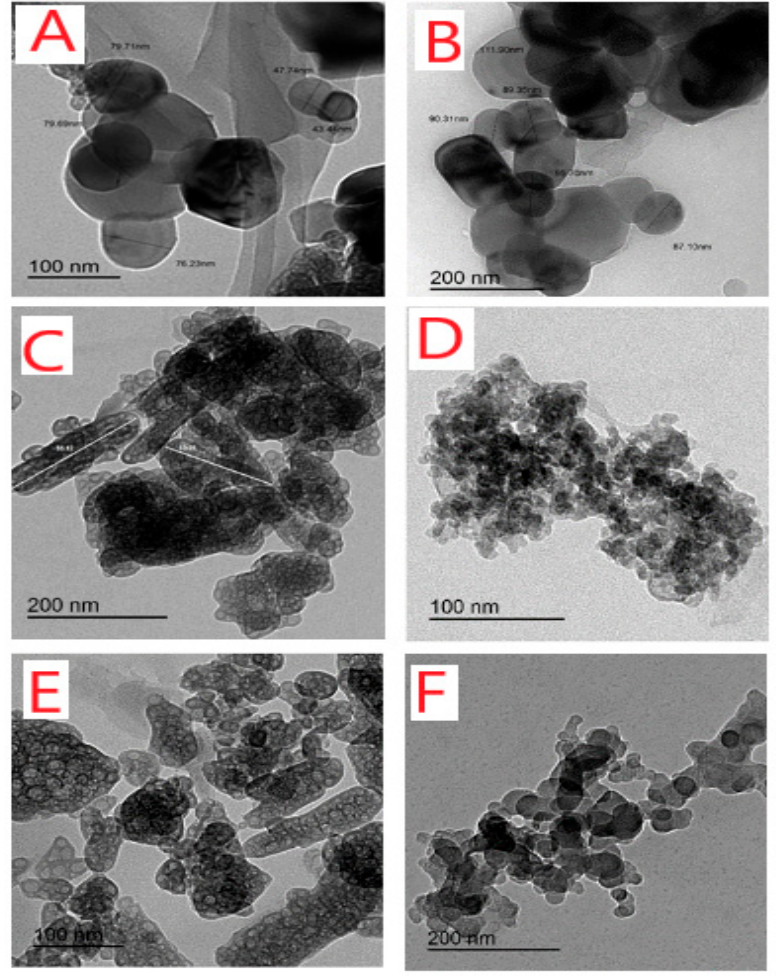
Figure 4. TEM images of ( A ) Mg(II), ( B ) Ca(II), ( C ) Cr(III), ( D ) Zn(II), ( E ) Cu(II), and ( F ) Se(IV) STG complexes.